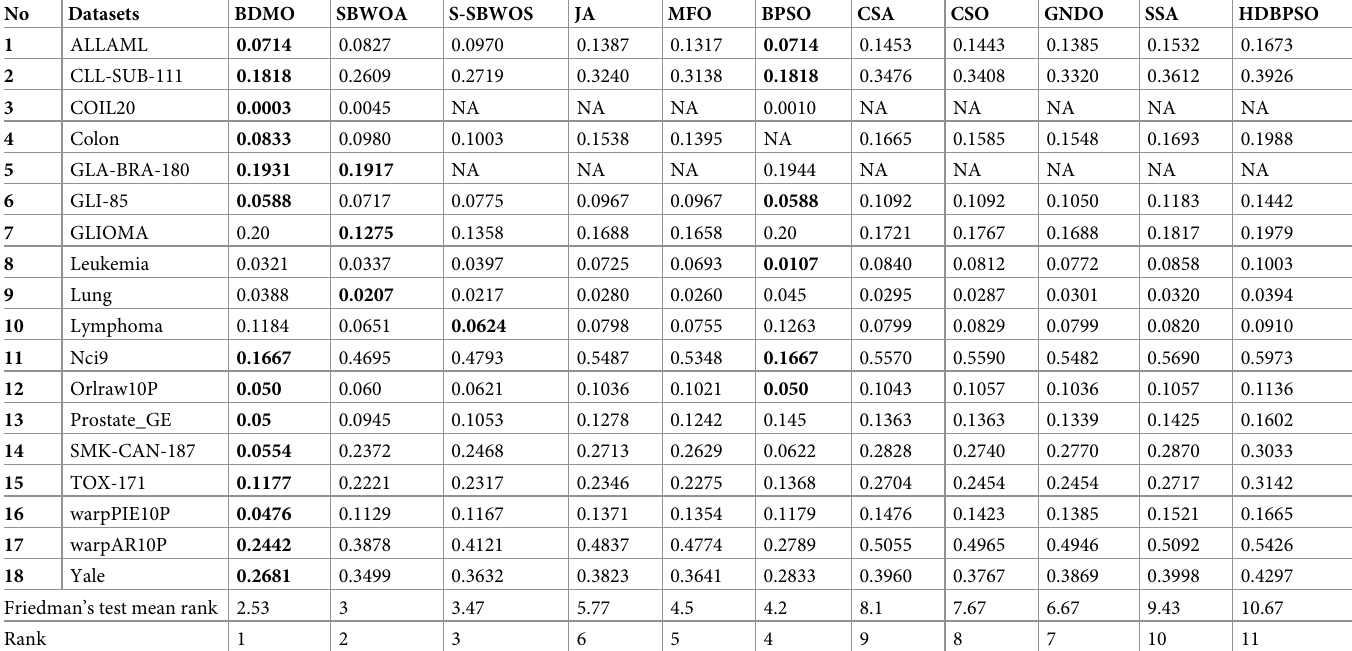
Table 3. Mean fitness values.